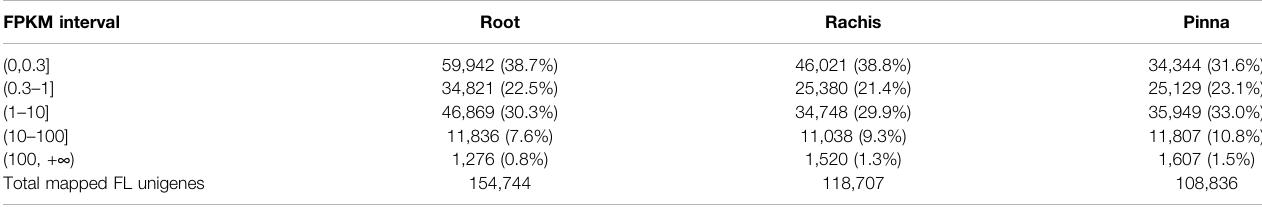
TABLE 3 | The expression characteristics of all 278,357 FL unigenes in three organs. FPKM interval Root Rachis Pinna